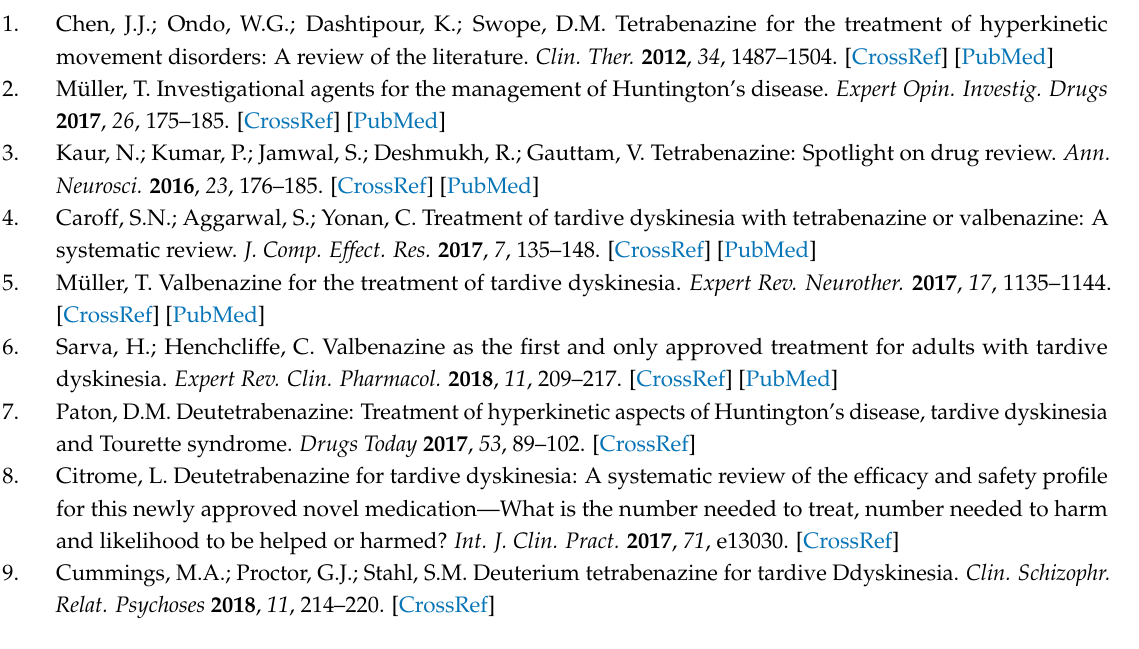
44/s1. Figure S1: LC-MS analysis; Figure S2: TBZ 500 MHz 1 H NMR spectra; Figure S3: Expanded TBZ 500 MHz 1 H NMR spectra; Figure S4: Deuterated TBZ 500 MHz 1 H NMR spectrum; Figure S5: ROESY experiments; Figure S6. LC-MS data for analyses of TBZ contained in ODF; Figure S7. Kinetic experiments on TBZ in D 2 O/acetic acid at 24 ◦ C; Figure S8. Kinetic experiments on TBZ in D 2 O/citric acid at variable